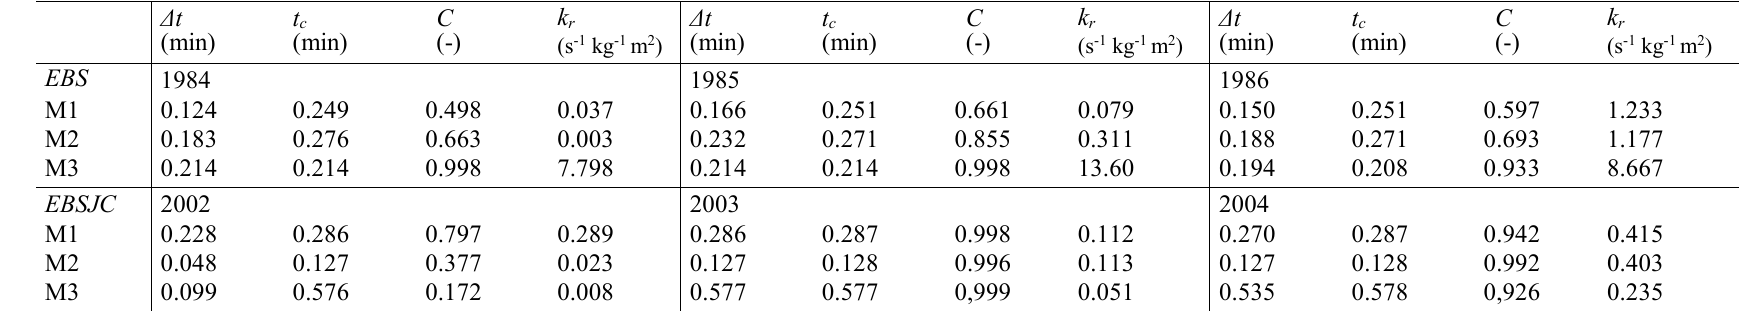
Table 1b EBS and EBSJC runoff coefficient of propagation (C = Δt/t c ) and Rainfall erosivity coefficient (k r